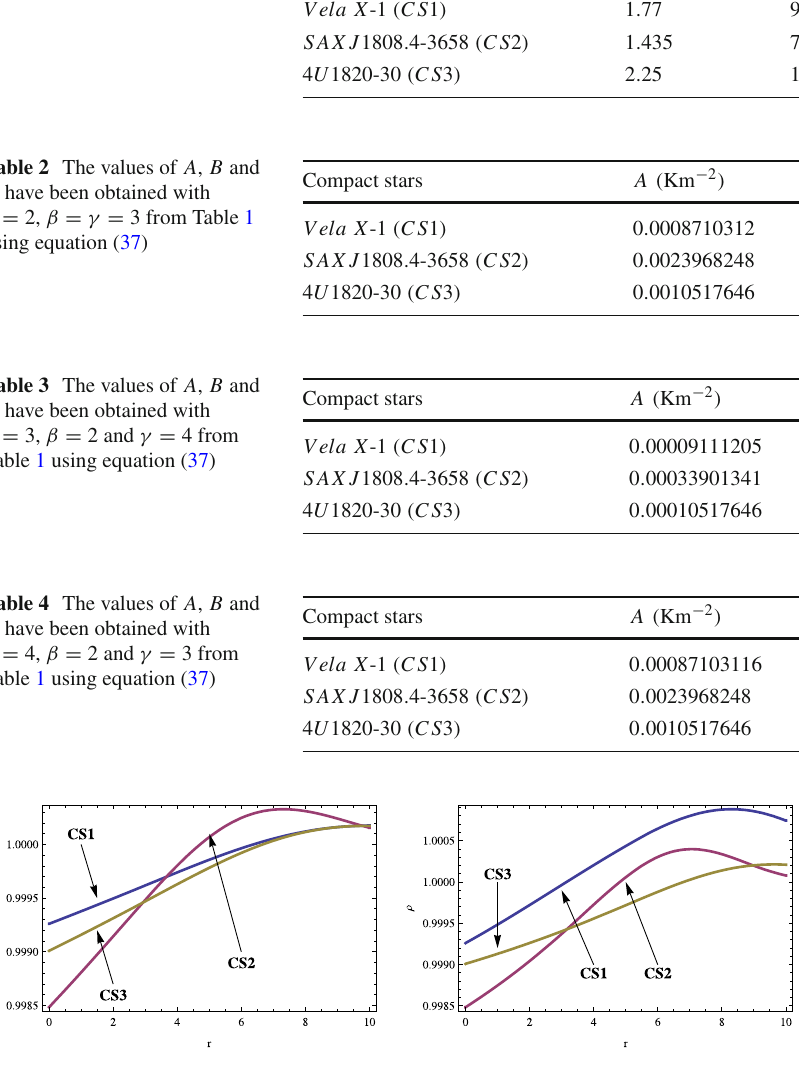
Fig. 1 Variations of energy density ρ ( MeV / f m 3 ) versus r ( km ) with the numerical values of A , B and C from Tables 2, 3 and 4 respectively